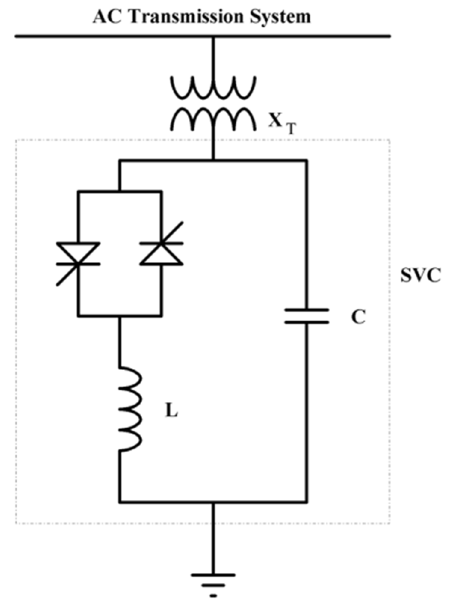
Figure 7. SVC power circuit.